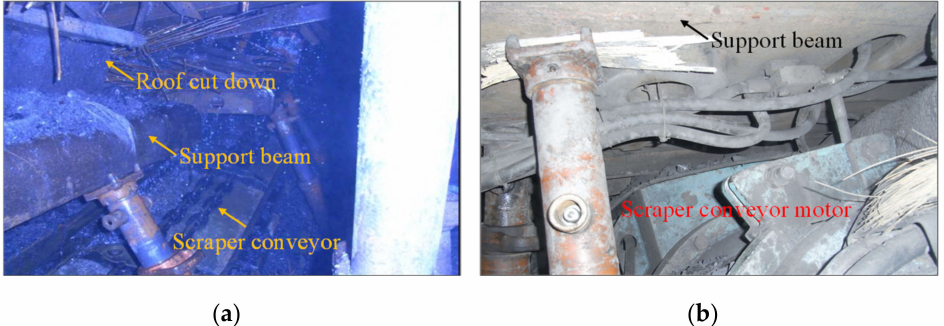
Figure 2. Actual water inrush and support crushing situation in the working face: ( a ) the central support crushed; ( b ) motor crushed at coal face